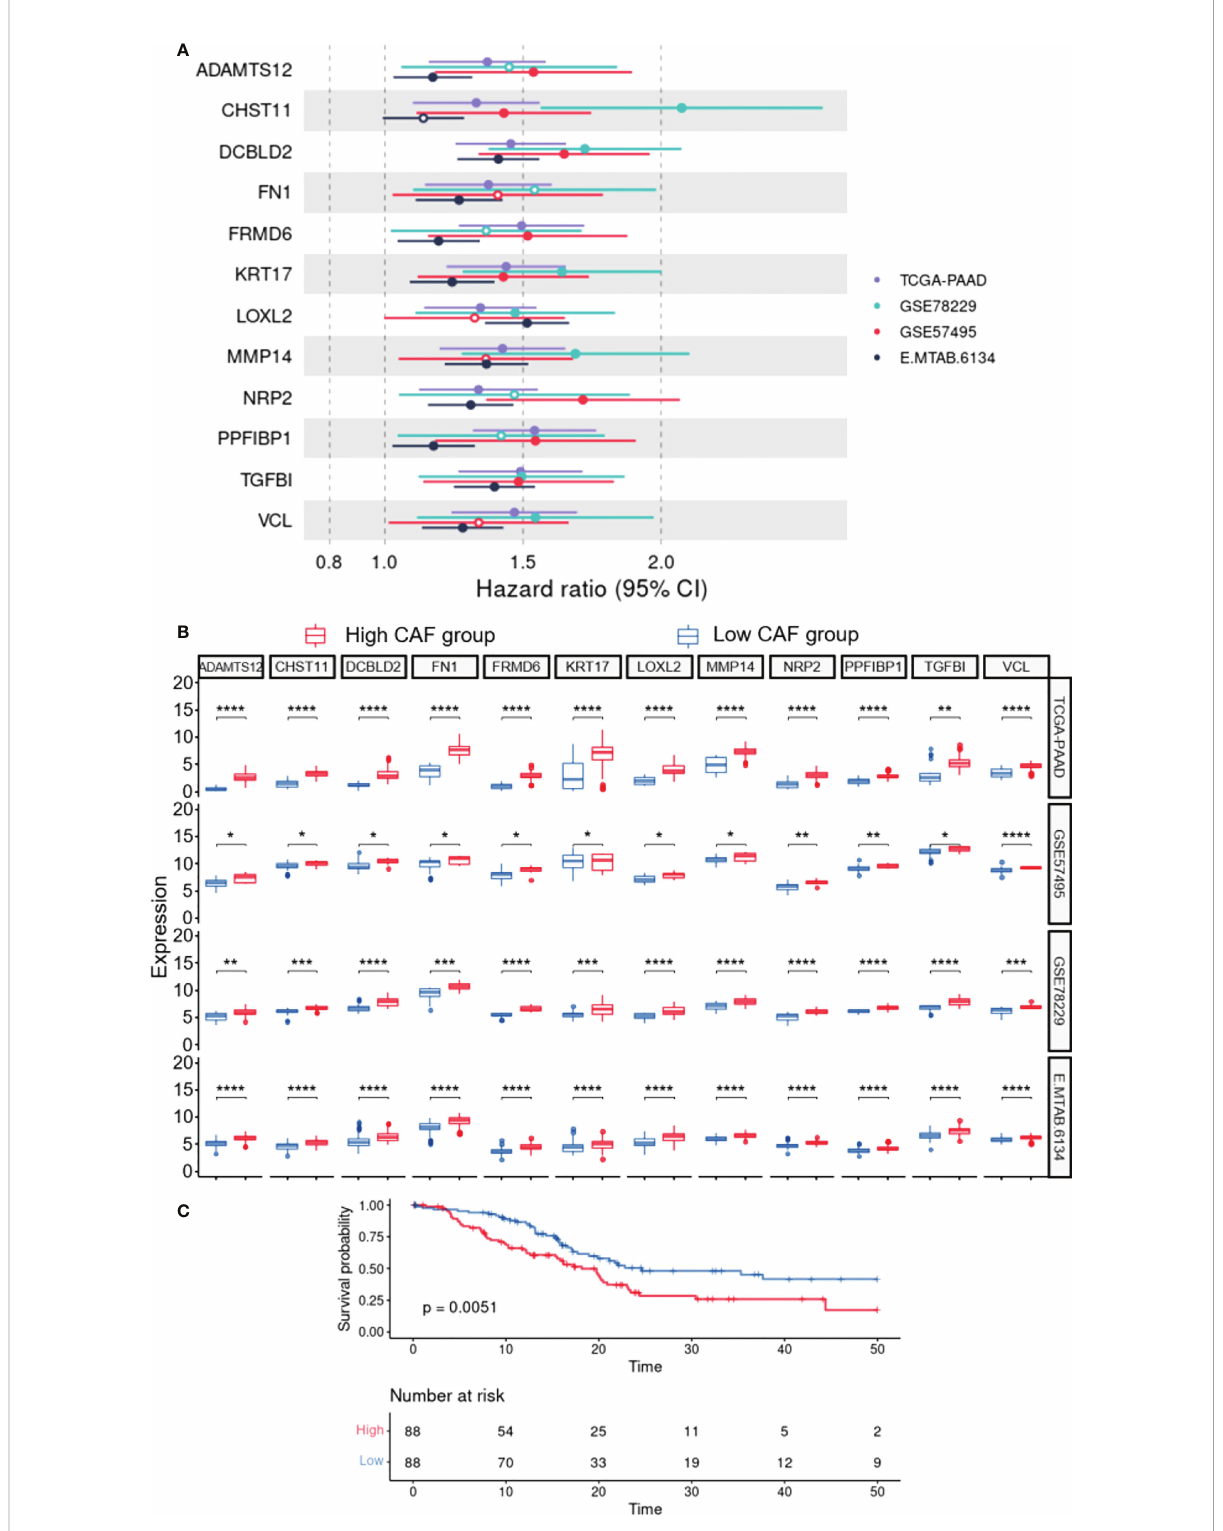
FIGURE 3 Construction of the CAF-based prognostic risk model. (A) , Forest plot representing Hazard ratio of each single gene used to construct the risk model. (B) , The expressions between worse and better survival groups across four datasets. (C) , Survival analysis reveals the association of the constructed risk model with overall survival in the TCGA-PAAD dataset (P=0.0051). * 0.01 < p-value < 0.05; ** 0.001 < p-value ≤ 0.01; *** 0.0001 < p-value ≤ 0.001; **** p-value ≤